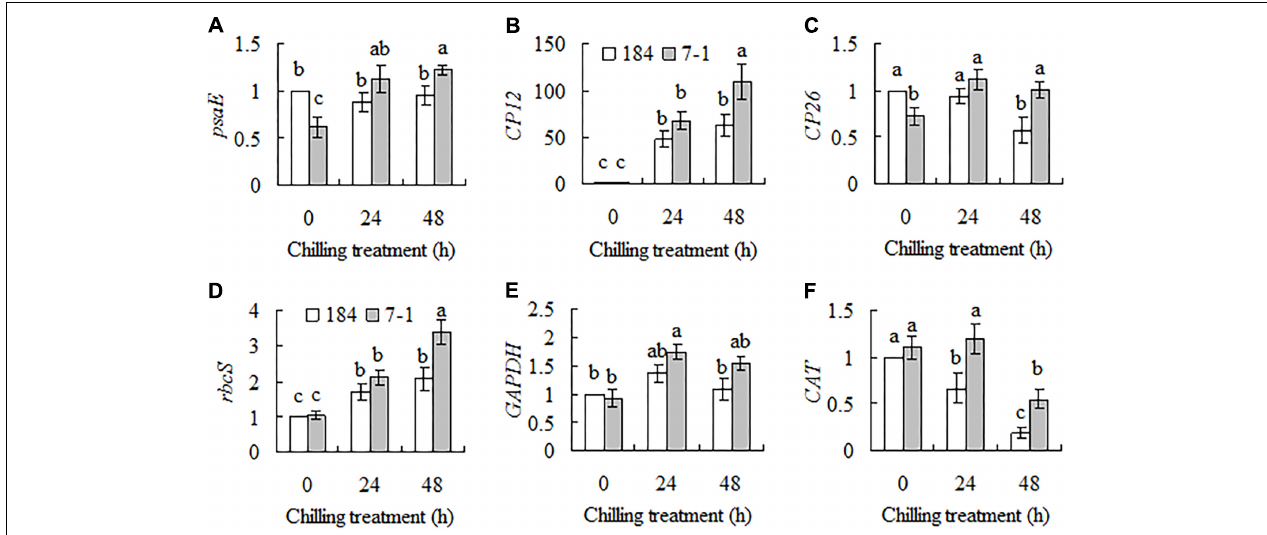
FIGURE 1 | Analysis of transcript levels of six genes, psaE (A) , CP12 (B) , CP26 (C) , rbcS (D) , GAPDH (E) , and CAT (F) , in response to chilling stress between the chilling tolerant mutant 7–1 and the wild type ( S. guianensis cv. CIAT184). Plants were placed in a growth chamber at 6 ◦ C for chilling treatment. Actin was used as reference gene for quantitative RT-PCR. Means of three replicates and standard errors are presented; the same letter above the column indicates no significant difference among the tested plant lines at P < 0.05.